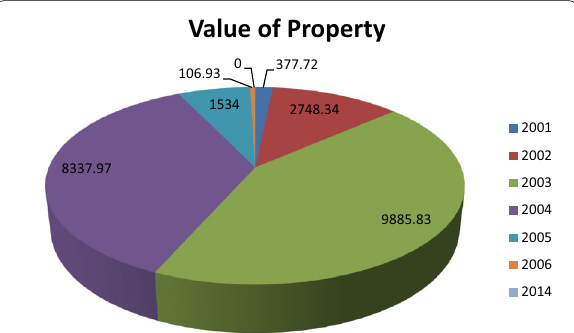
Fig. 2 Yearwise area eroded due to Riverbank erosion in Assam. Source: Water resource Department, GOA